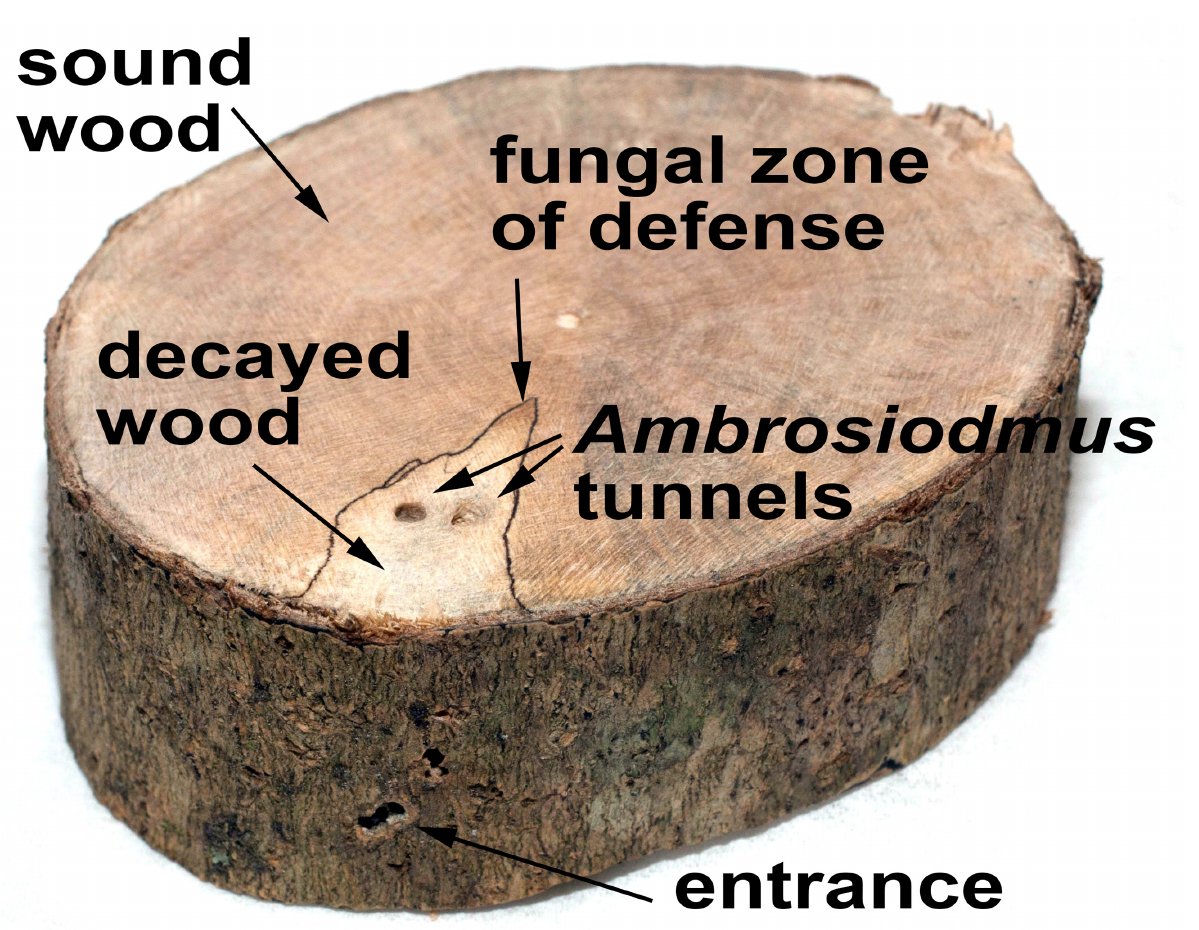
Fig 2. Wood decay as a result of colonization by the Ambrosiodmus-Flavodon